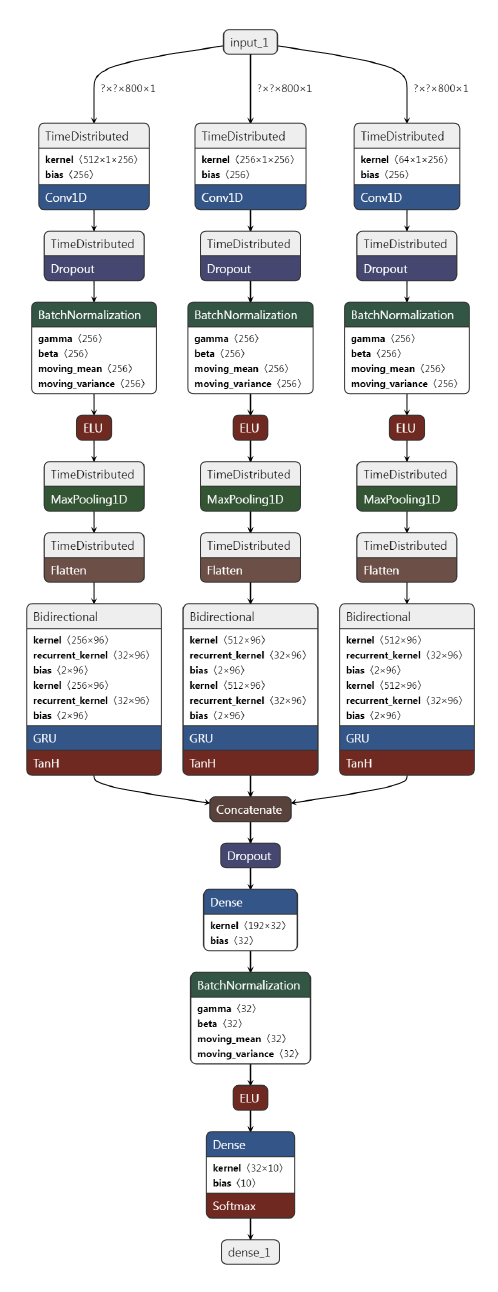
Figure 3. Proposed method